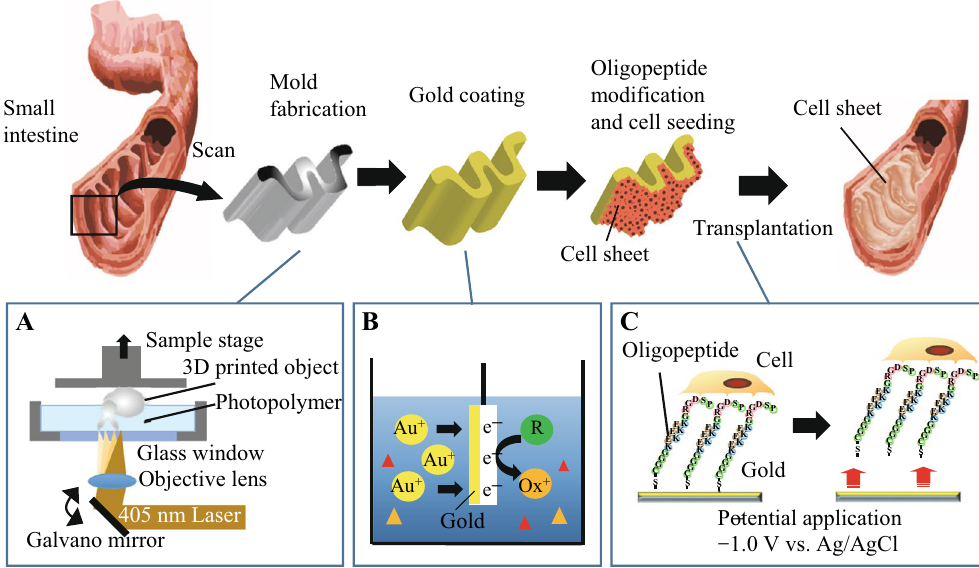
Figure 1. Strategies for transplanting tailor-made cell sheets using electrochemical cell detachment. ( A ) Fabrication of a 3D mold corresponding to a surgery site using microstereolithography. ( B ) Electroless gold plating onto the fabricated mold. ( C ) Direct transplantation using electrochemical cell detachment. A cell sheet was detached and transferred along with electrochemical desorption of the oligopeptide